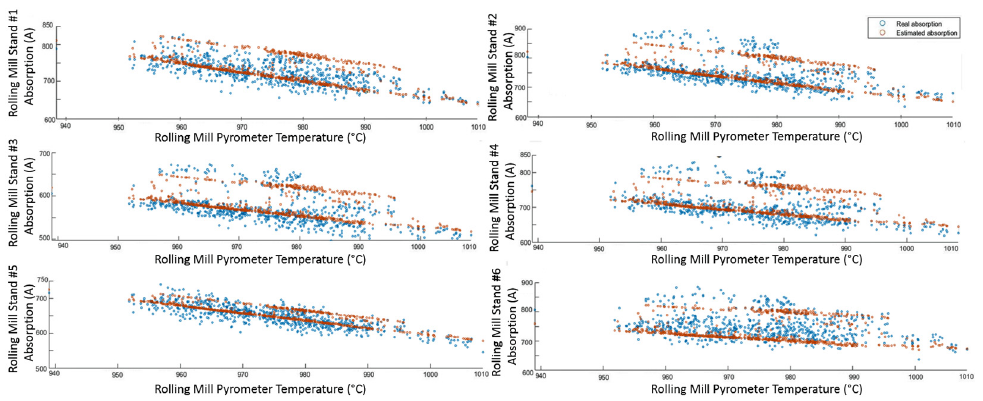
Figure 7. Modelization results: billets rolling mill stand absorption model.